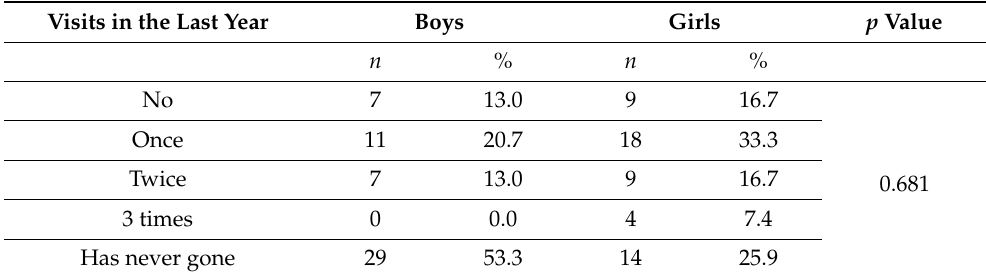
Table 7. Comparison of dental visits by sex in the